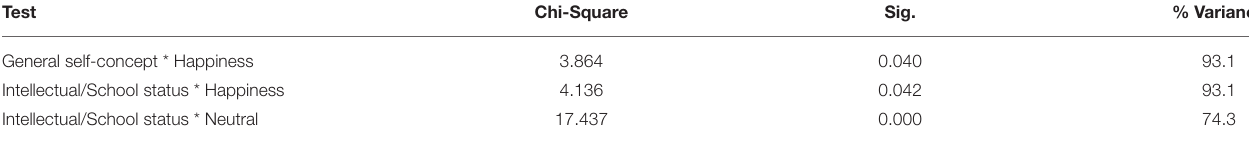
TABLE 2 | Significant effects of binomial logistic regression relating self-concept and emotion recognition.